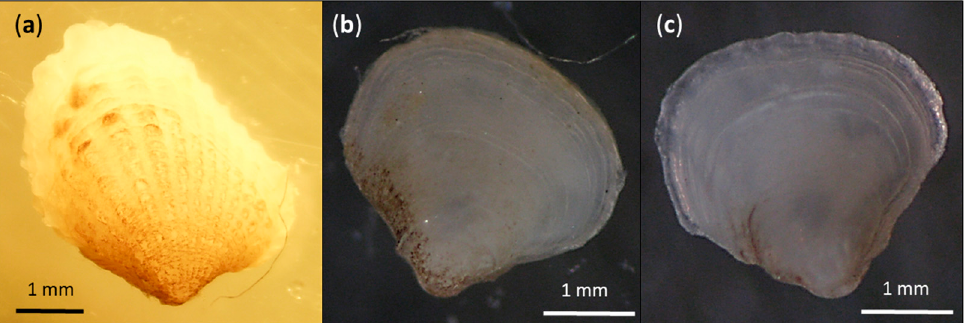
Figure 3. Different developmental stages of Cardita calyculata with morphological features that vary for individuals with only a few millimeters difference in size. BOLD Process IDs and GenBank Accession numbers are: ( a ) CROMI035-19, MT920126, ( b ) CROMI020-19, MT920128, ( c ) CROMI017-19, MT920129. In Table S5: ( a ) = Species 3c, ( b ) = Species 3e and ( c ) = Species 3a.